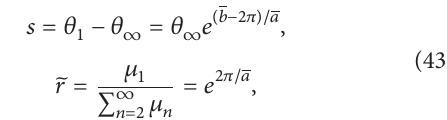
+ 0.0015 , 𝑢 + 0.0025 , and 𝑢 + 0.0035 from the bottom to top. ps ps ps ) for 𝑞/2𝑀 = 0 , 0.3, and 0.42 from the bottom to ps